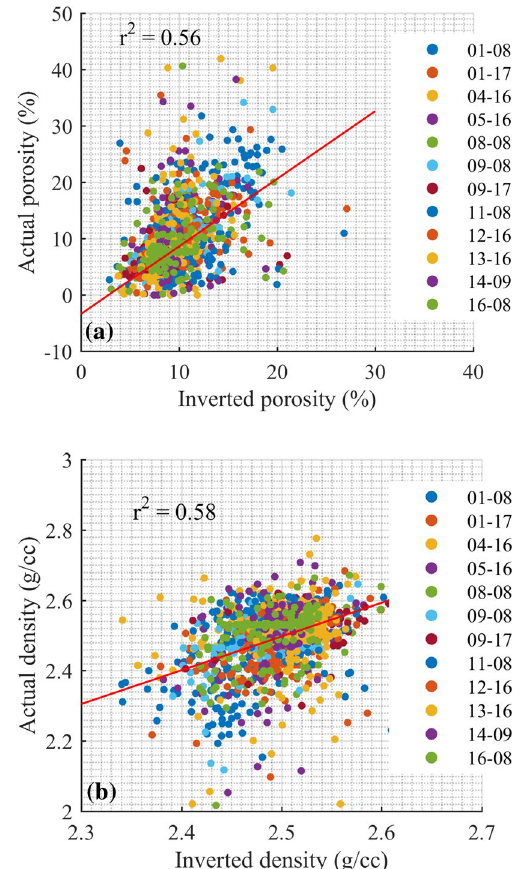
Fig. 10 Cross-plot of a predicted porosity versus actual porosity and b predicted density versus actual density from all the wells. The dis- tribution of scatter points indicates the performance of MAA tech- niques